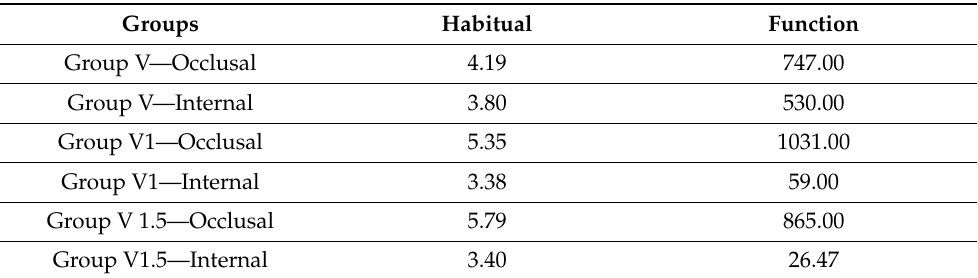
Figure 3. Distribution of the maximum principal stress in the occlusal, middle, and cervical thirds of the aesthetic facets, with buccal view and their interfaces in each group, with usual loading and simulated chewing. Table 3. Maximum principal stress (MPa) in modification crowns groups with habitual loading and simulating function with loading in the central